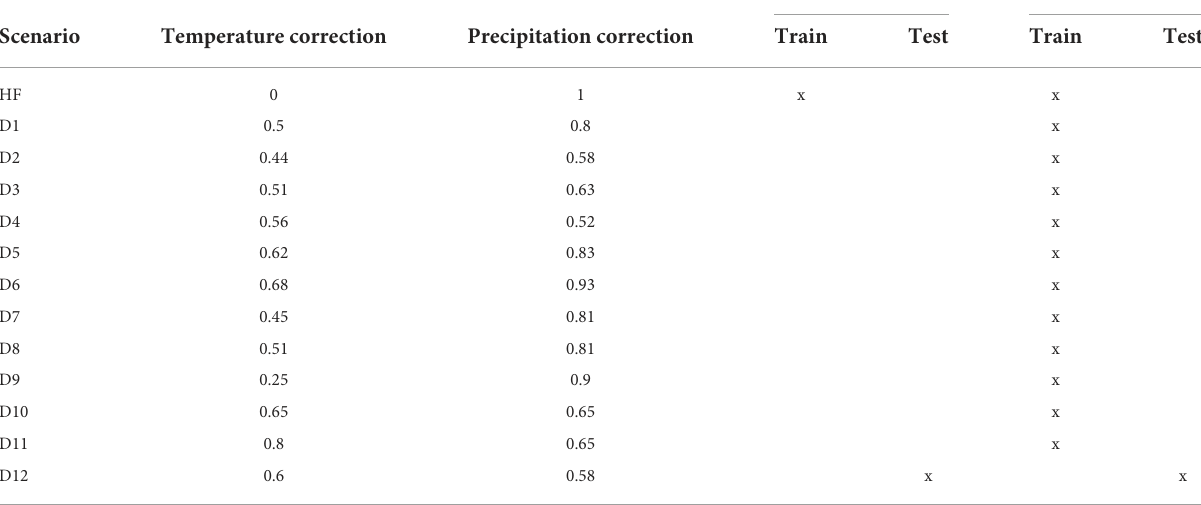
TABLE 1 The first 3 columns summarize the forcing scenarios run with ParFlow-CLM and used for the training and testing of the machine learning models.